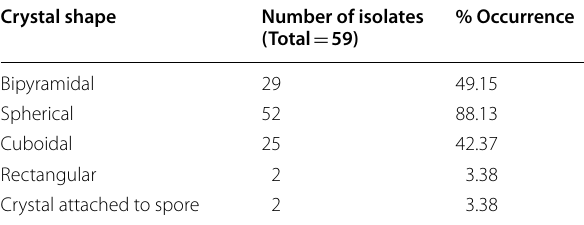
* HD1 and 78/11 are standard strains Table 2 Crystal morphology of Bacillus thuringiensis isolates Table 3 Crystal protein profile and cry genes distribution